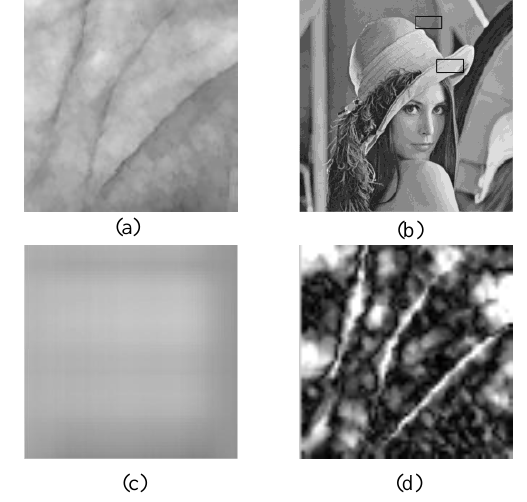
Fig. 2. (a) Palmprint, (b) cover image, (c) reconstructed palmprint, (d) secret image (shown as absolute difference between (a) and (c) and magnified by a factor